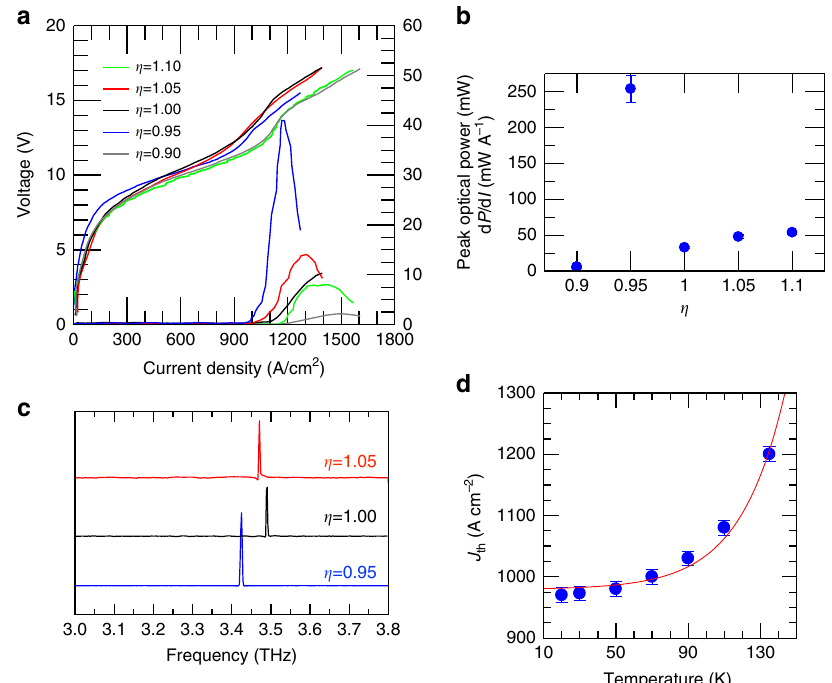
Fig. 3 Electrical and optical characterization. a Voltage – current density ( V – J ) and power – current density ( L – J ) characteristics measured at 20 K for a set of devices with different η values, in a nitrogen-purged atmosphere. All lasers are driven in pulsed mode with a pulse width of 200 ns and pulse repetition rate of 100 kHz. Optical power scales were corrected to account for the detector collection ef fi ciency and the absorption of the polyethylene cryostat window. The device area is 0.074 mm 2 . b Slope ef fi ciency measured at 20 K plotted as a function of η , under the same experimental conditions shown in a , with error bars derived from the linear fi tting procedure of the slope. c Fourier transform infrared emission spectra for selected devices from a , measured in rapid scan mode. d Threshold current density of the device with η = 0.95 as a function of the heat-sink temperature. The red line is the fi t based on the empirical formula J th ( T ) = J 1 + J 2 exp( T / T 2 ). The error bars account for errors on the extrapolated threshold current